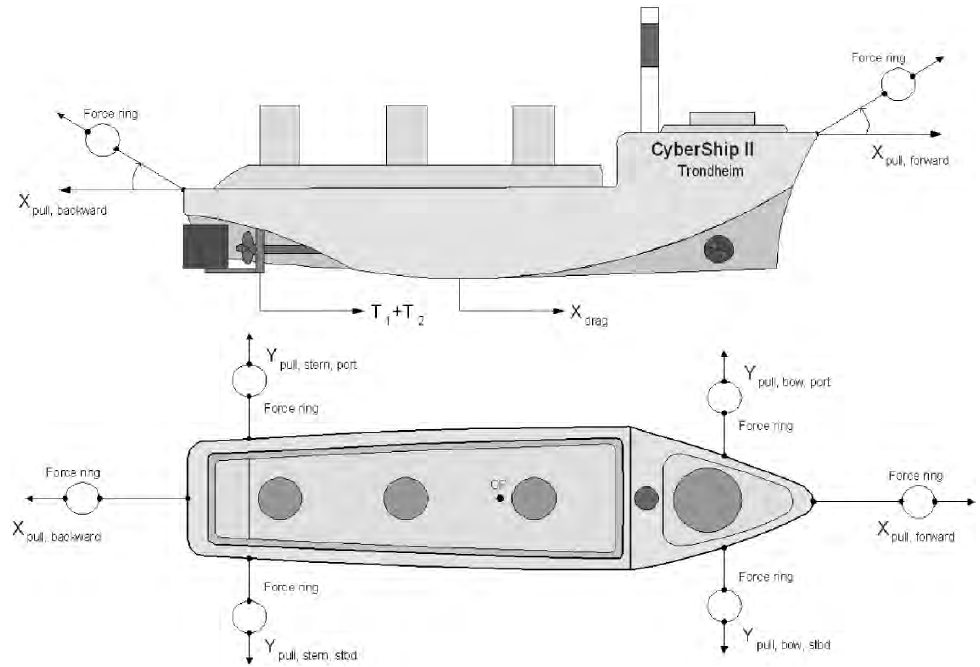
Figure 4. Two force rings, forward and backward, were applied to measure the drag and propulsion forces when towing CyberShip II longitudinally at di ff erent speeds. Four force rings, two port and two starboard, were used to measure the drag force and moment for lateral